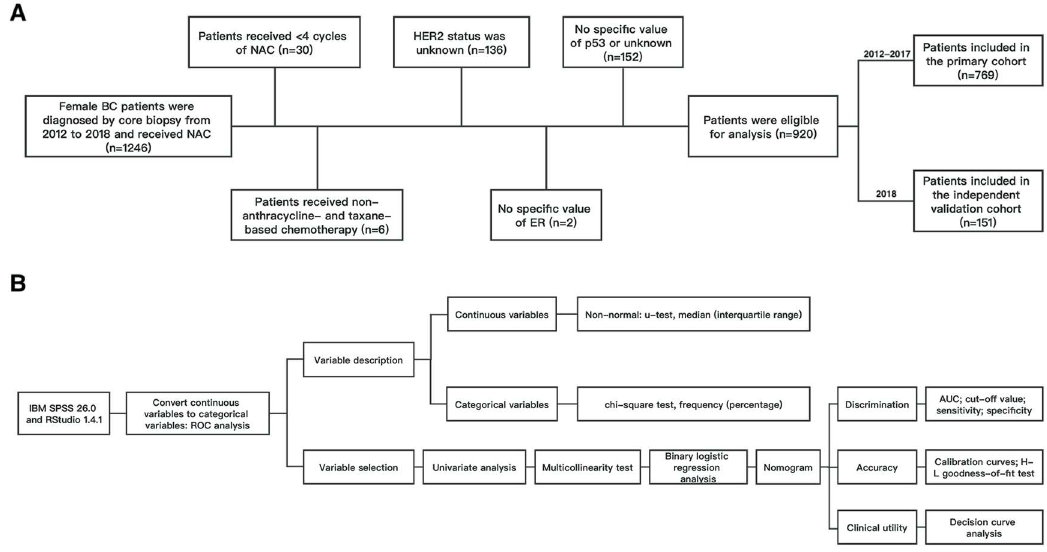
Figure 1. Flow chart of ( A ) patient selection; ( B ) statistical process. Abbreviations: BC, breast cancer; NAC, neoadjuvant chemotherapy; HER2, human epidermal growth factor receptor 2; ER, estrogen receptor; ROC, receiver operating characteristic; AUC, area under the